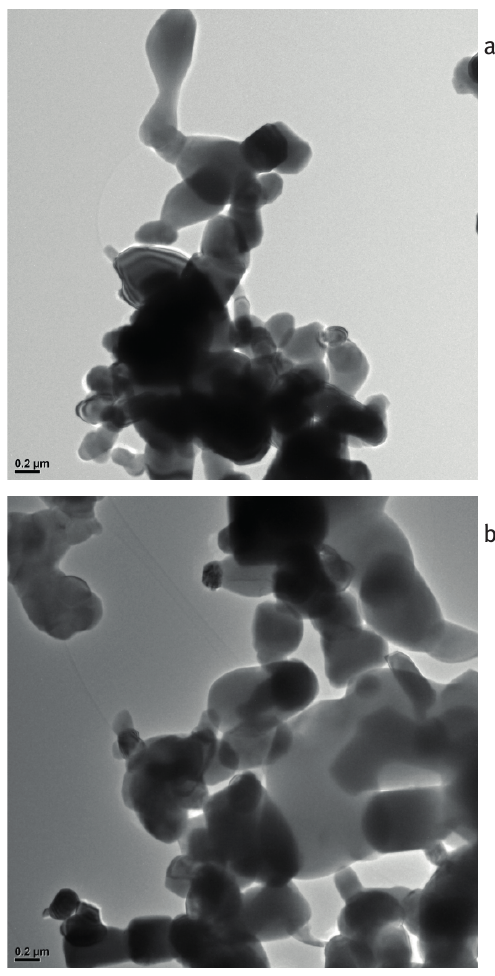
Figure 6: TEMBF (Transmission Electron Microscopy Bright Field) images: (a) HA treated at 1050°C, (b) HA – ZnO treated at 1050°C. Table 2: The fractal analysis of HA-Zn to 1050 0